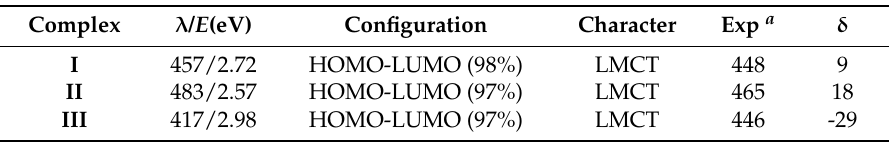
Table 5. Calculated phosphorescent emission (in nm) of the studied clusters I – III with TD-DFT method, along with experimental